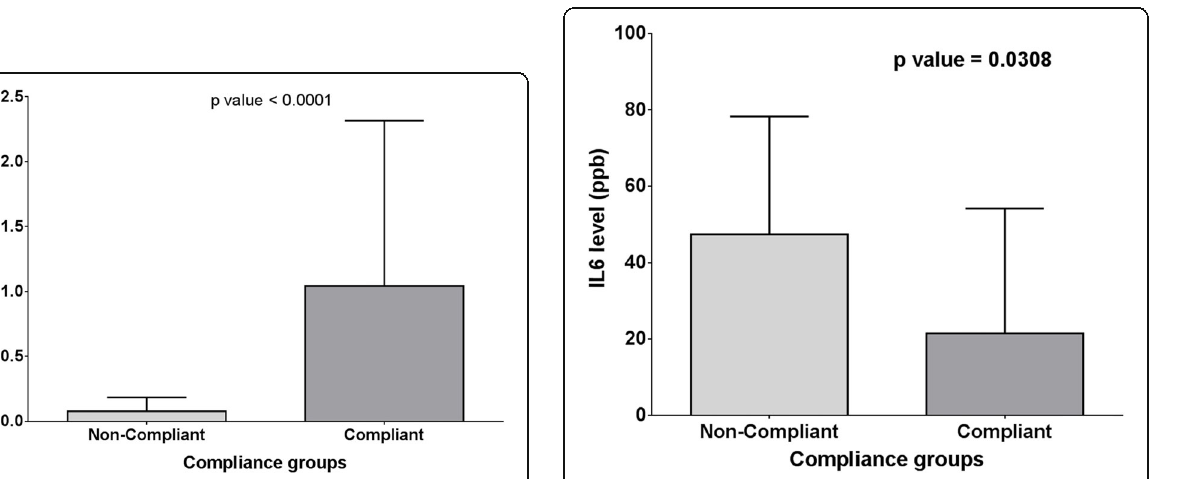
Fig. 6 Mean and SD of LAP compliance groups